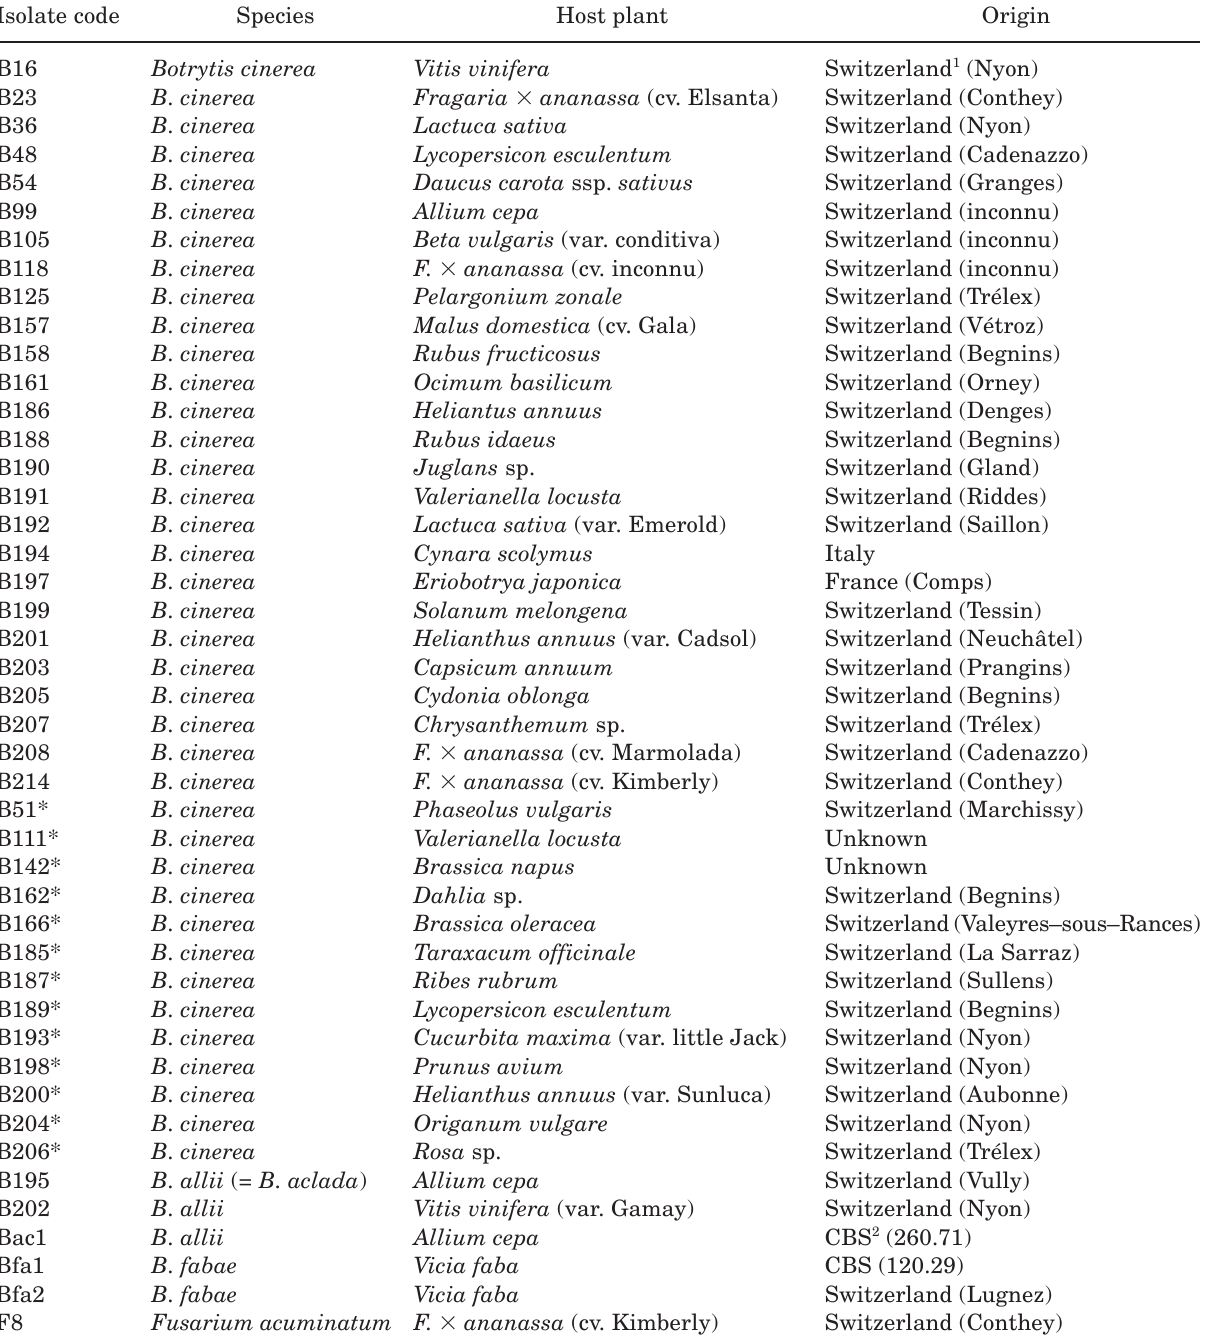
Table 1. Code and origin of fungal isolates. Isolate